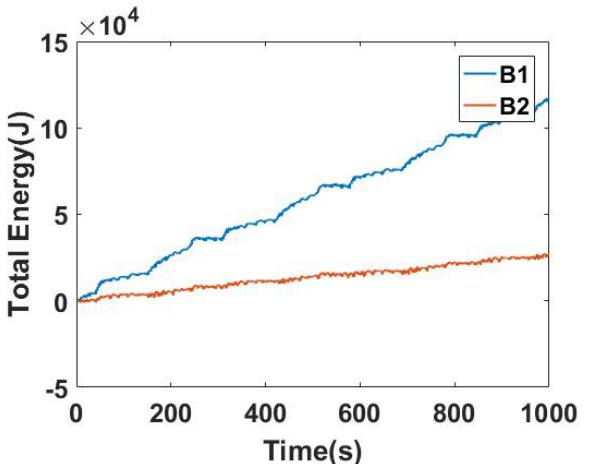
Fig. 5: The energy extracted from the first and the second mass with control limitation 7000 N and mooring stiffness 5 × 10 4 N/m.